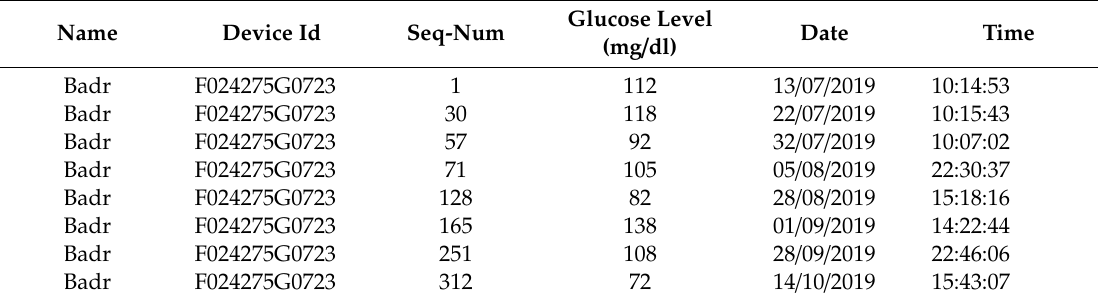
Table 3. Glucose level storage for a patient.